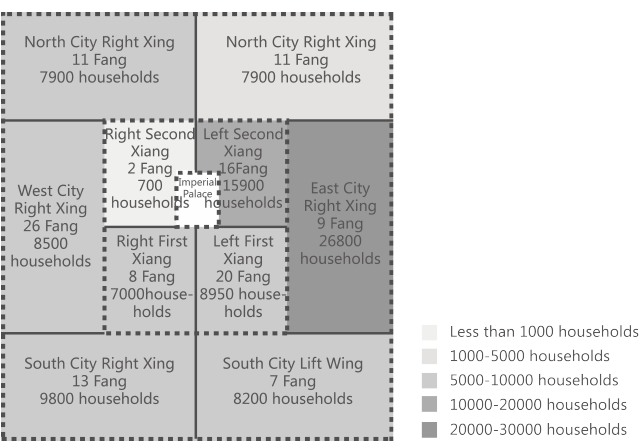
Figure 24. the number of Fangs and households in the city in the fifth year of the Tianxi period of the Northern Song Dynasty, with reference to the composition of the Dongjing Jie-Shi system in the Northern Song Dynasty